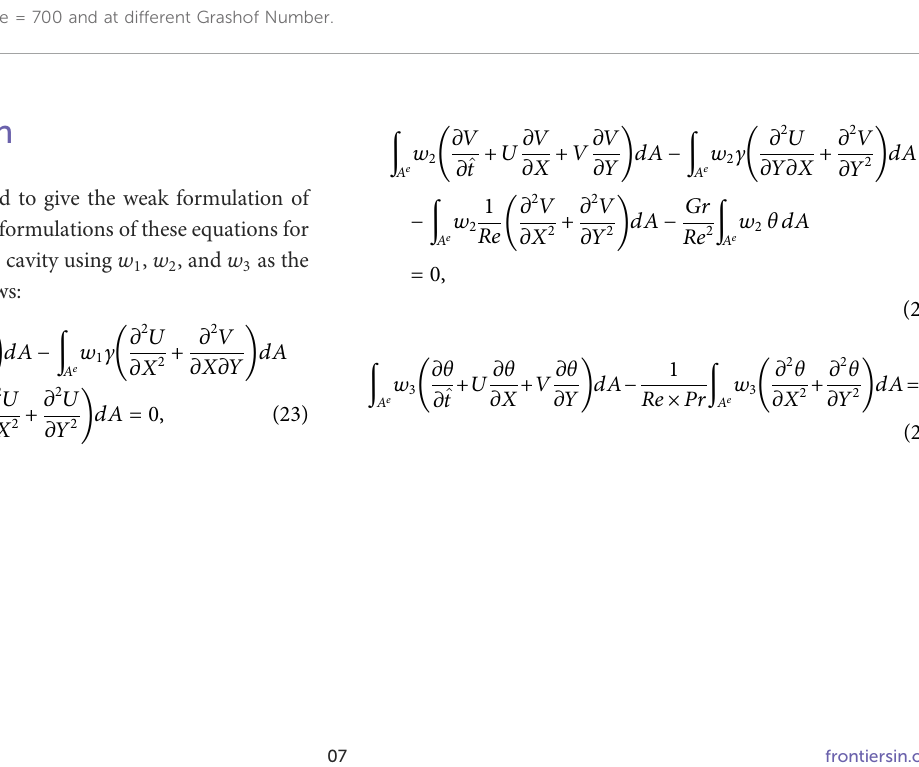
Temperature distribution at Re = 700 and at different Grashof